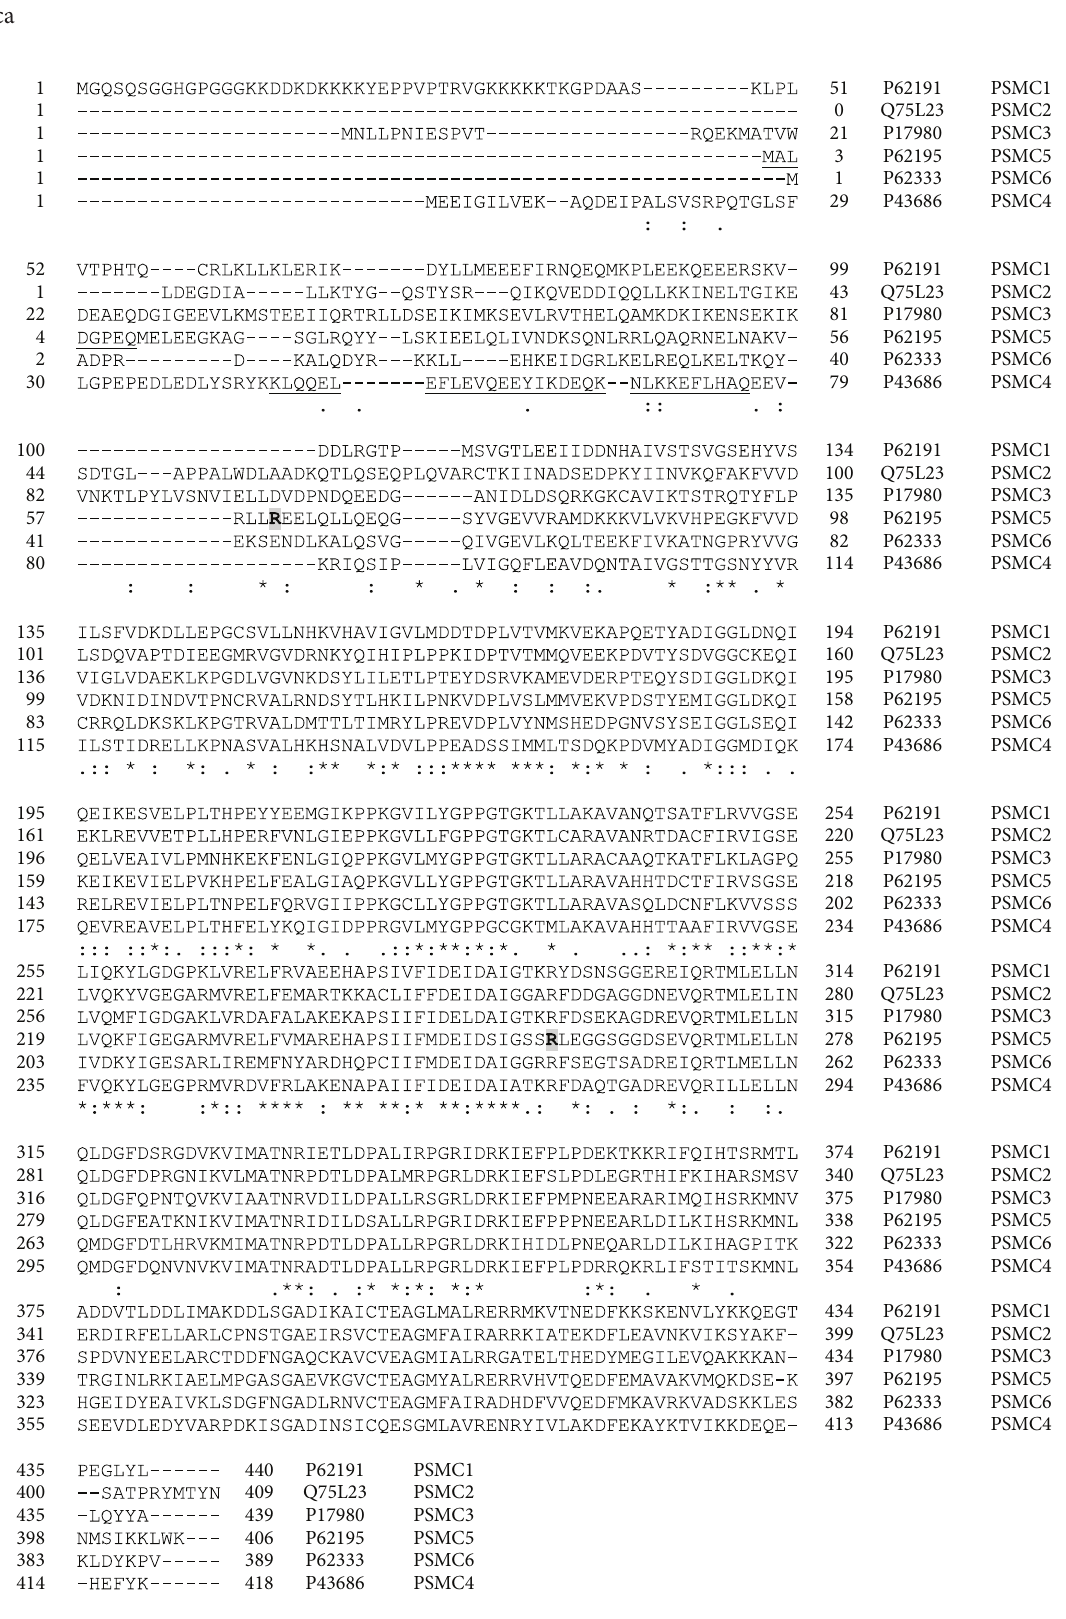
Figure 9: Alignment of human PSMC subunits 1–6. Protein sequences of the six proteasome PSMC subunits were aligned using Clustal W. ⋆ , identical residue in all six subunits; :, conserved amino acids with strongly similar properties; ., conservation between residues of weakly similar properties. Naturally occurring variants are highlighted with grey boxes. Alternatively spliced regions are underlined. Amino acid residue numbers are shown on the left and right of each sequence and the UniProt accession number and gene name of each sequence are shown to the right of each